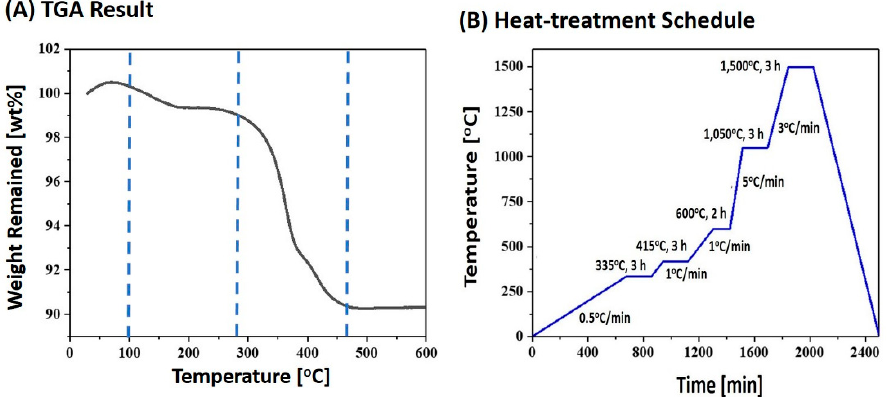
Figure 1. ( A ) TGA result of an as-manufactured 4Y-PSZ component as a function of temperature ( B ) heat-treatment schedule for debinding with a multi-step debinding using slow heating rates below 600 °C to avoid the formation of defects and sintering at 1500 °C for 3 h.